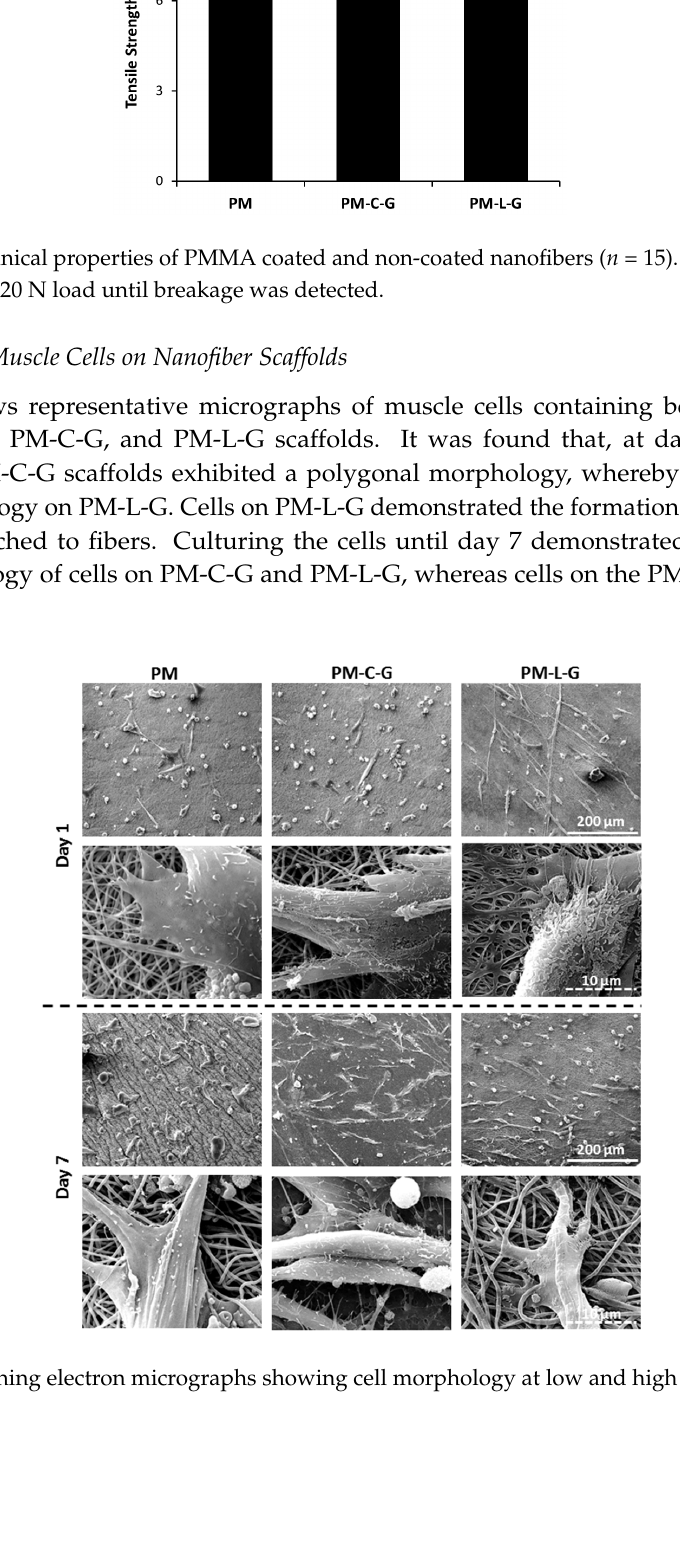
Figure 6. Scanning electron micrographs showing cell morphology at low and high magnification.